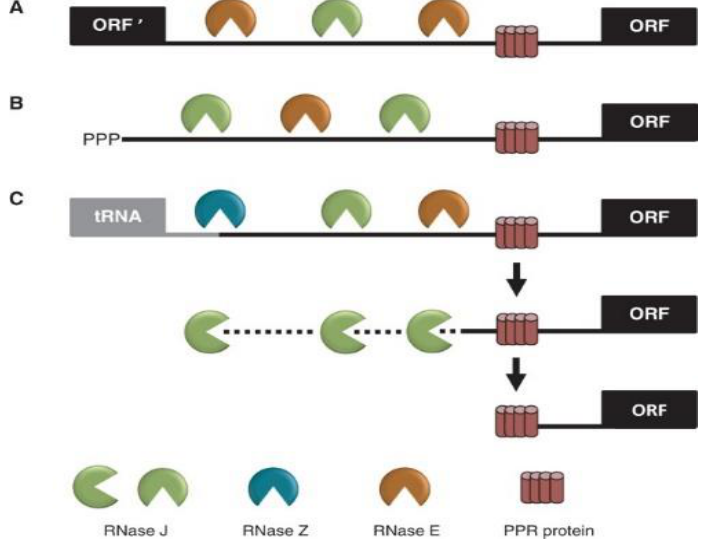
Figure 5. Model for the involvement of RNase J in processing chloroplast RNA 5′ ends defined by PPR proteins. Maturation of a generic mRNA (open reading frame, ORF) 5′ end is shown here. Precursor transcripts originate from polycistronic ( A ) and monocistronic ( B ) transcriptional units, as well as readthrough transcripts from upstream genes such as tRNAs ( C ). Processing is initiated by endonucleolytic cleavages by RNase J or RNase E within unstructured intergenic regions or, in the case of tRNAs, by RNase Z. The resultant 5′ ends are subsequently trimmed to their mature forms by the exonuclease activity of RNase J at PPR protein-bound sites. (Acquired with copyright permission from [67]).